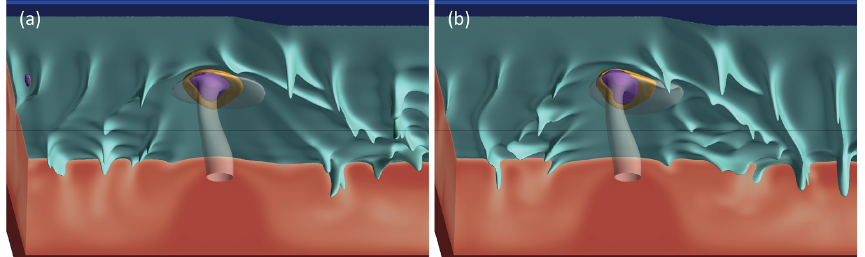
Figure 10. Steady-state model snapshot for the low-viscosity cases ( η 0 = 5 . 53 × 10 18 Pas). (a) Case with D plume = 200km and B plume = 200kgs − 1 . (b) Case with D plume = 300km and B plume = 200kgs − 1 . Note that the deflection of the pancake at 300km is greater than at 200km (Fig. 9) as opposed to the case for intermediate and high